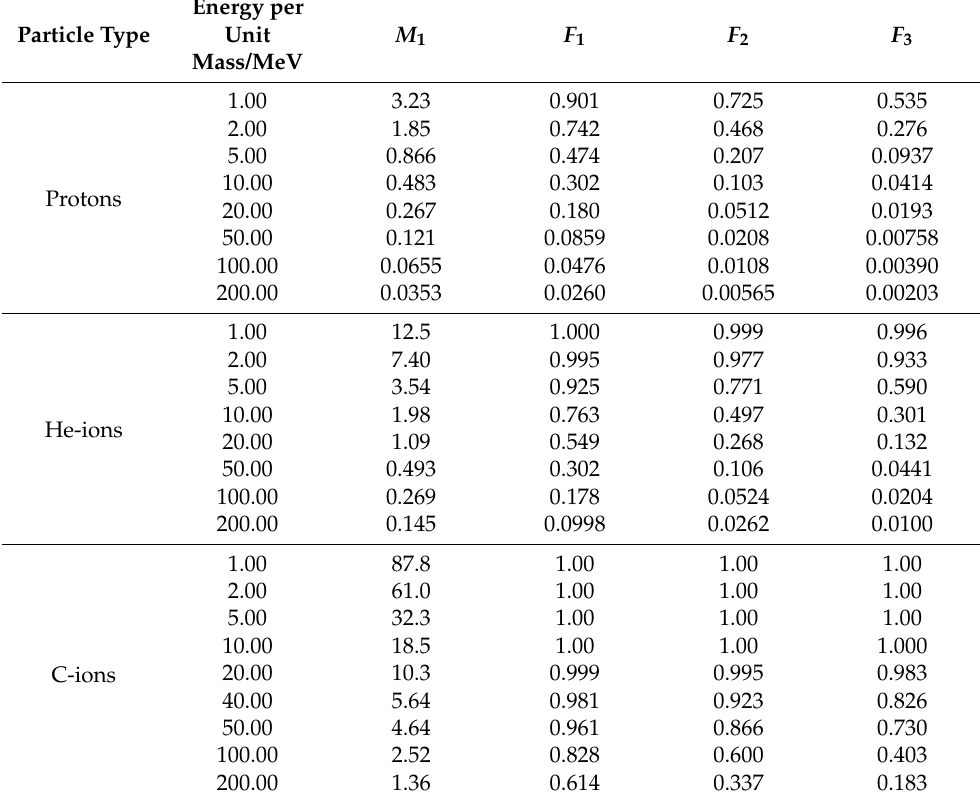
Table A3. Nanodosimetric quantities for protons, helium and carbon ions in a sphere of D = 5